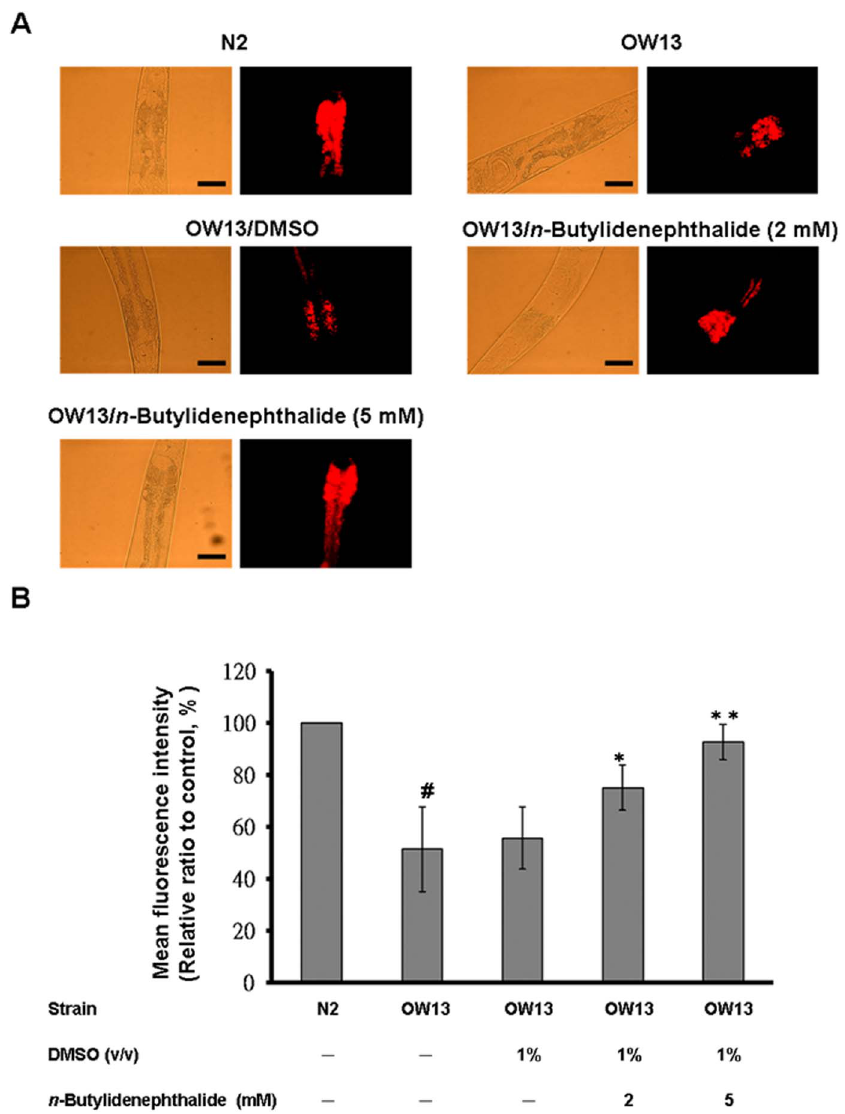
Figure 5. n -Butylidenephthalide elevates lipid content in the OW13 strain of C.elegans . (A) Nile red staining pattern in transgenic C. elegans strain OW13. The left side shows the differential interference contrast (DIC) image. The right side shows fluorescence images. Scale bar, 50 m m. (B) Graphical representation for fluorescence intensity of the Nile red pattern in transgenic C. elegans strain OW13 as quantified using AxioVision software. The data represent the mean 6 SD (n=10). A hash ( # ) indicates significant differences between N2 and OW13 animals ( p , 0.01); an asterisk (*) indicates significant differences between the OW13 control samples and the n -butylidenephthalide-treated samples ( * p , 0.05, ** p , 0.01).